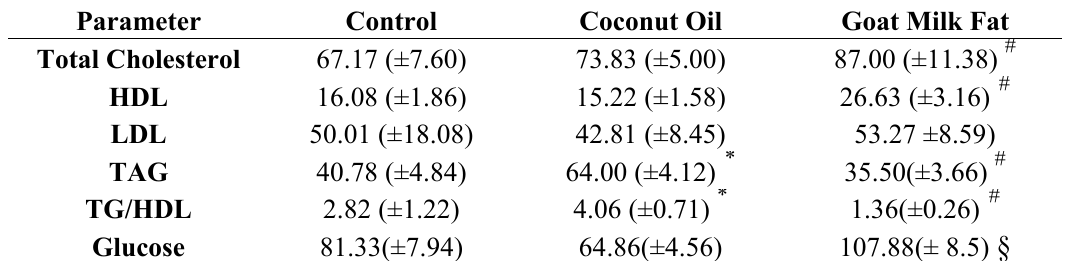
Table 1. Means values for total cholesterol (CT), HDL-cholesterol (HDL), triglycerides (TG), TG/HDL ratio and glucose from animals treated with different lipids source during ten